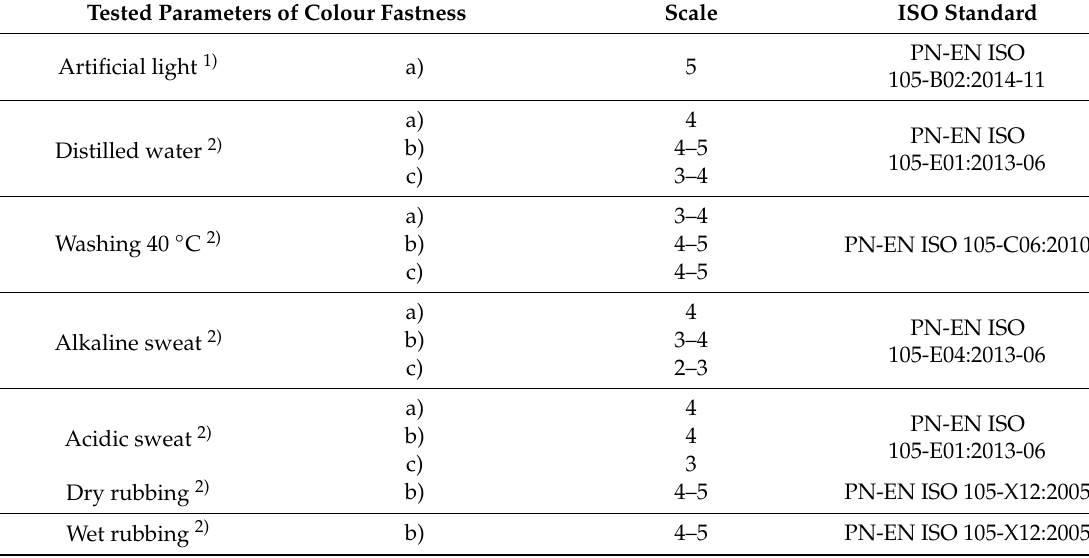
Table 4. Colour fastness of wool fabric dyed with the AB2 dye at a concentration of 1%.